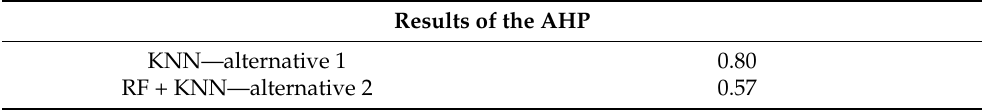
Table 6. Evaluating the classifier with the